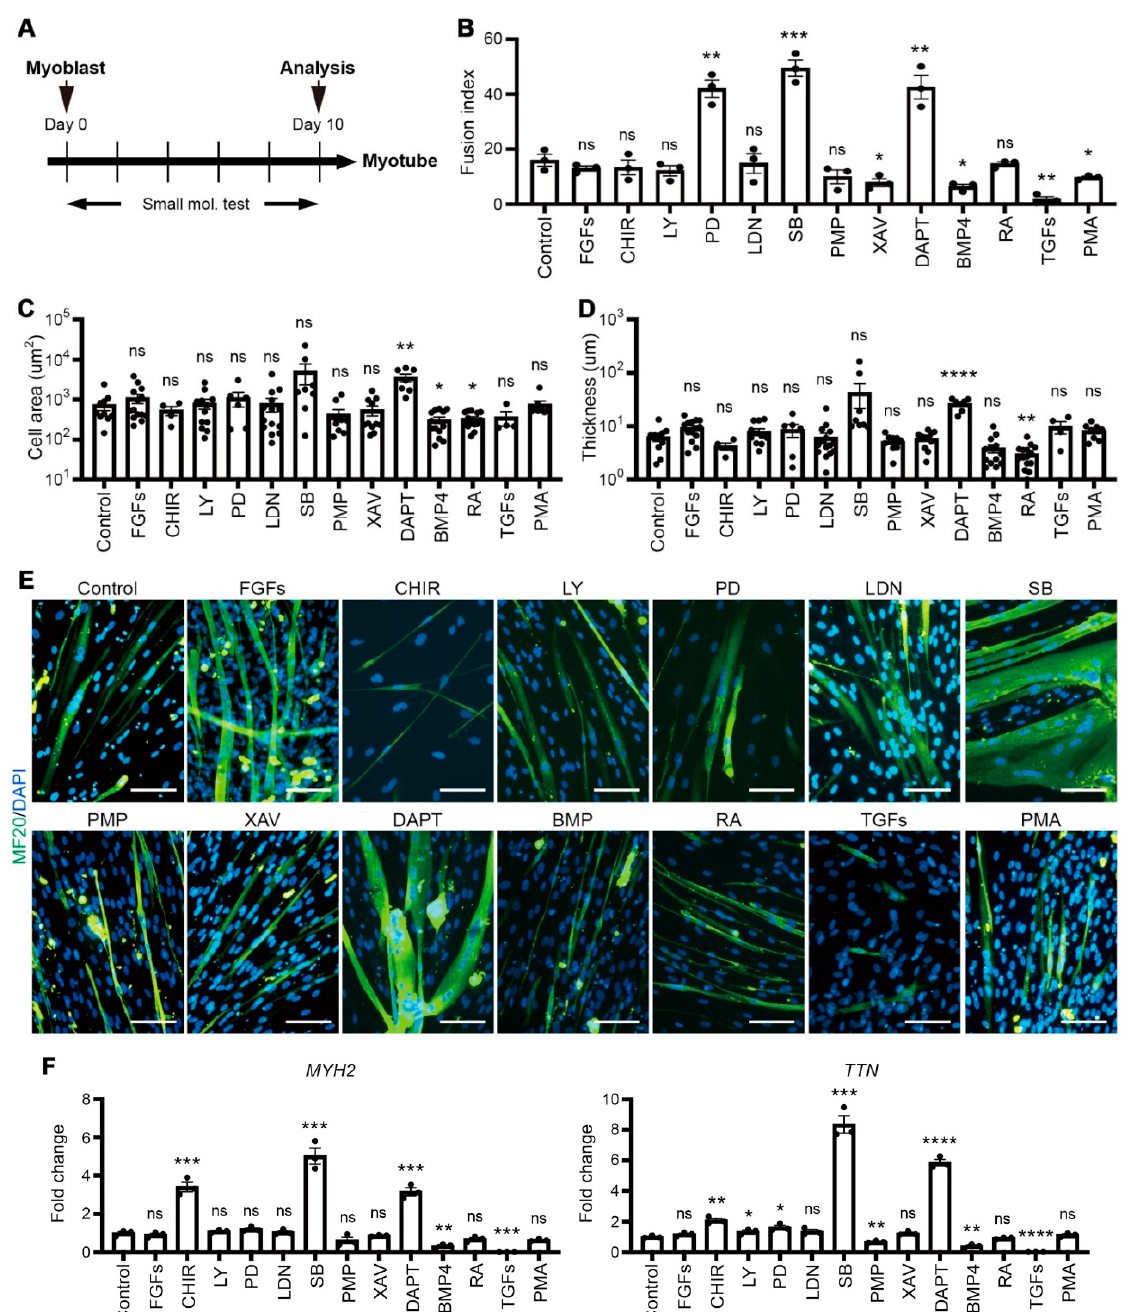
Figure 2. Small scale screening of small molecules for enhancing myoblasts fusion efficiency. ( A ) Experimental strategy for small molecule compound screening to enhance myotube formation. hiPSCs derived myoblasts were plated onto 48 well plates and cultured for 10 days with or without small molecules, and the fusion index was determined at day 10. ( B ) The fusion index analysis of myotubes that were differentiated with each small molecule. ( C ) The area of individual myotubes stained with MF20 with each small molecule. ( D ) The thickness of individual myotubes stained with MF20 with each small molecule. ( E ) Expression of MF20 on differentiated myotube with each small molecule treatment individually. ( F ) Fold changes of expression levels with myotube-specific marker genes, MYH2 and TTN in 14 different conditions. Scale bars = 100 um. * p < 0.05, ** p < 0.01, *** p < 0.001, **** p < 0.0001, ns = non significance, One-way